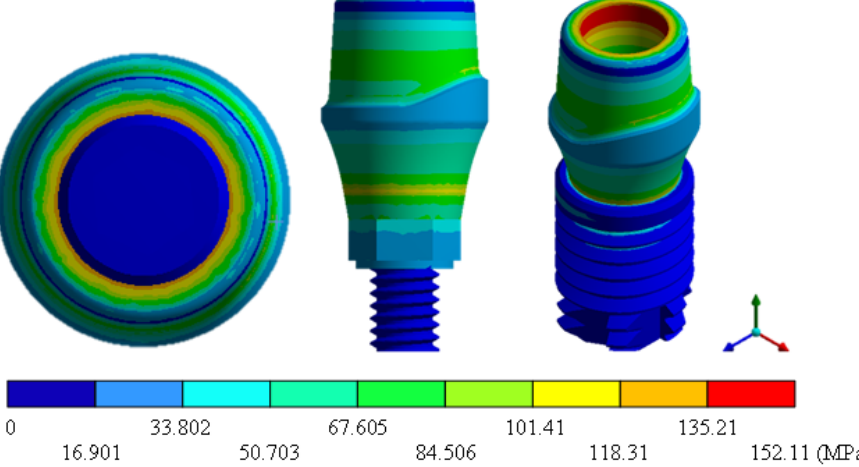
Figure 16. Von Mises stress for On1 Esthethic-type implant (Ti 6 Al 4